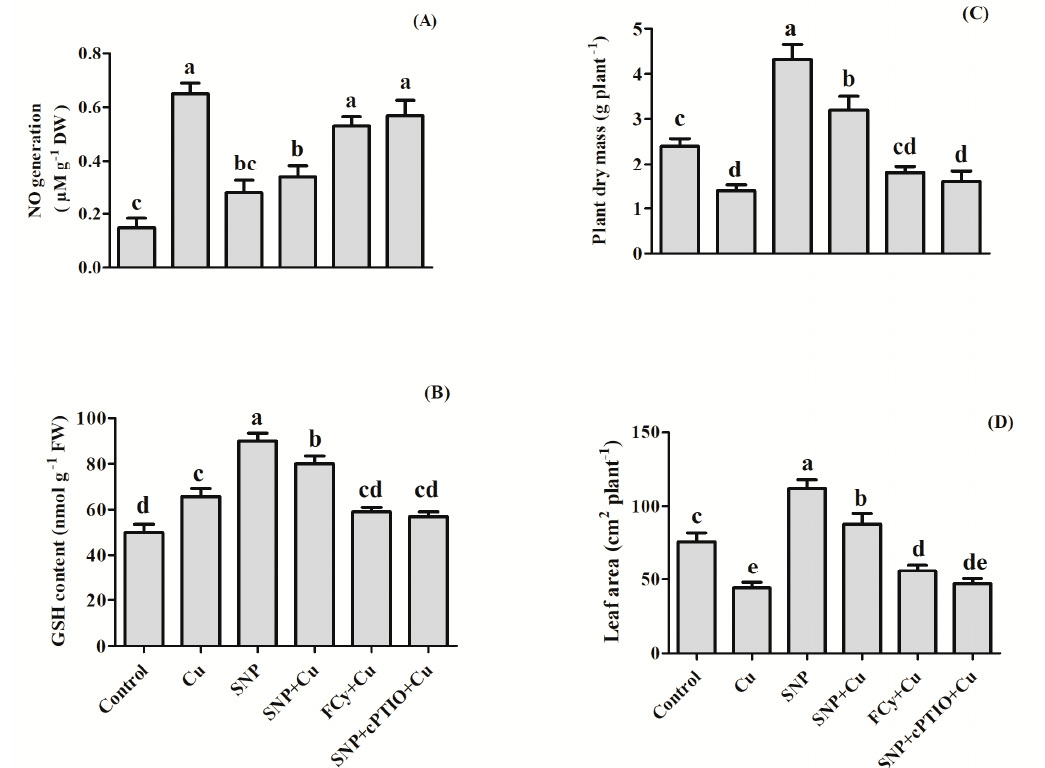
Figure 13. Effect of NO on NO generation ( A ) , GSH ( B ), plant dry mass ( C ) and leaf area ( D ) of Indian mustard ( Brassica juncea L.) treated during pre-germination with water, 100 µM SNP or SNP with cPTIO and FCy in presence or absence of 3 mM Cu at 30 DAG. Same letter above bars show that data did not differ significantly by LSD test at p < 0.05. FW—fresh weight; DW—dry weight.